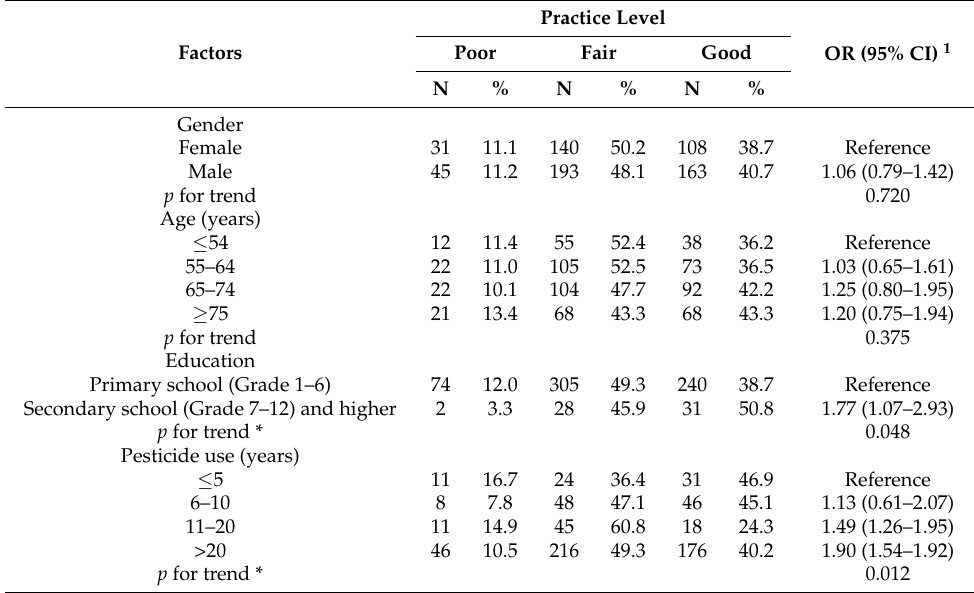
Table 3. Associations between demographic and practice level (N =